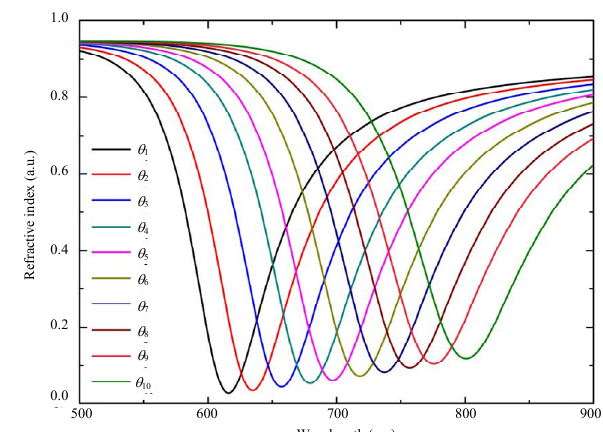
Fig. 2 Typical SPR reflectivity curves at different incident angles (the reflectivity curves from left to right correspond to incident angles θ 1 , θ 2 , θ 3 , θ 4 , θ 5 , θ 6 , θ 7 , θ 8 , θ 9 , and θ 10 , respectively).